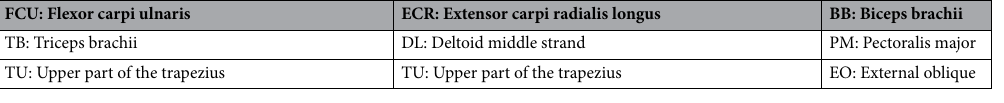
Table 1. We measured and analyzed the muscles summarized in this table on the right and left sides of the